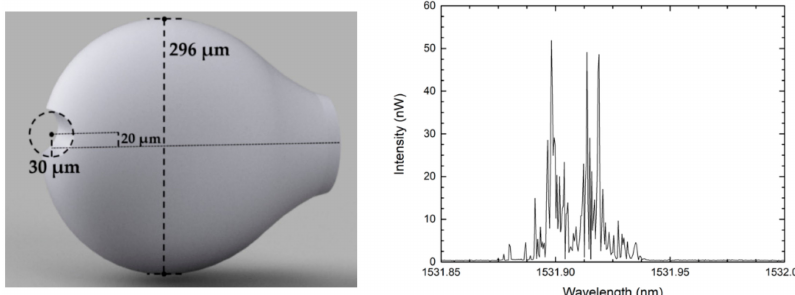
Figure 6. Schematic diagram of a circular-milled microsphere and output signal, when using the microsphere in the ring structure illustrated in Figure